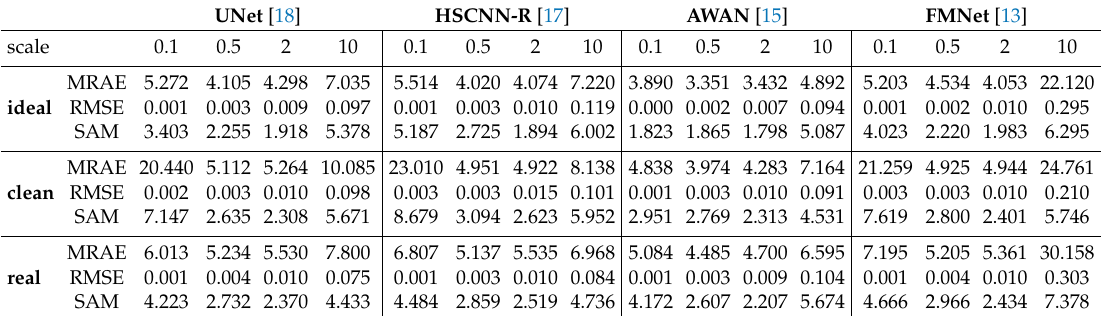
Table 3. Average reconstruction metrics for varying scales assuming the original workflow—spectral super-resolution (SSR). SAM is reported in degree, MRAE in